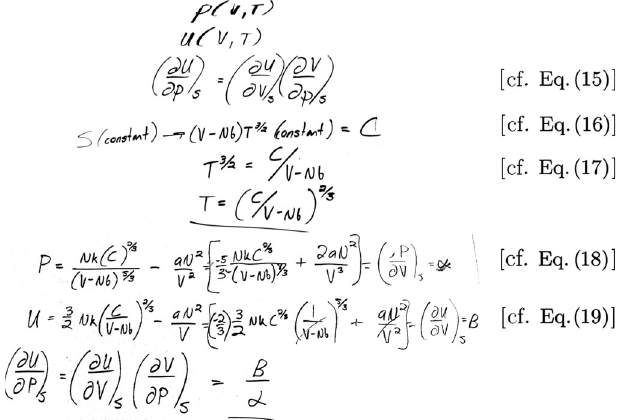
FIG. 2. Leo’s written work that demonstrates the use of con- stant entropy as a constraint (Sec.